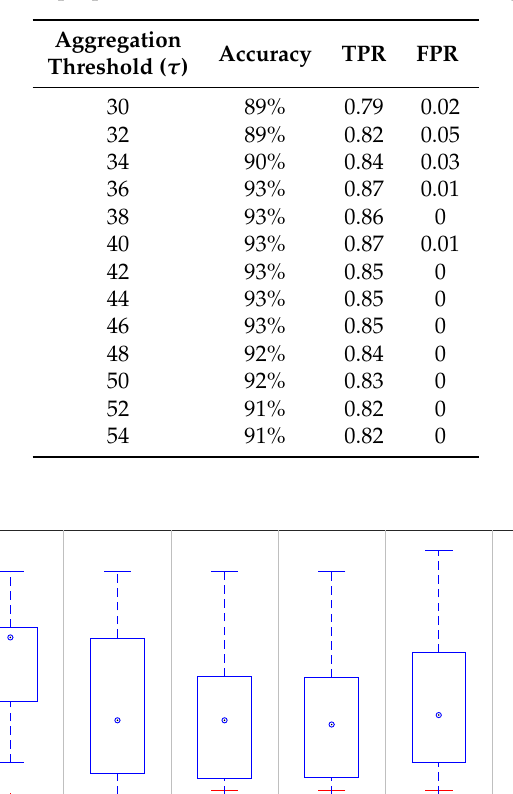
Table 5. Performance of the proposed method for different values of the aggregation threshold τ .